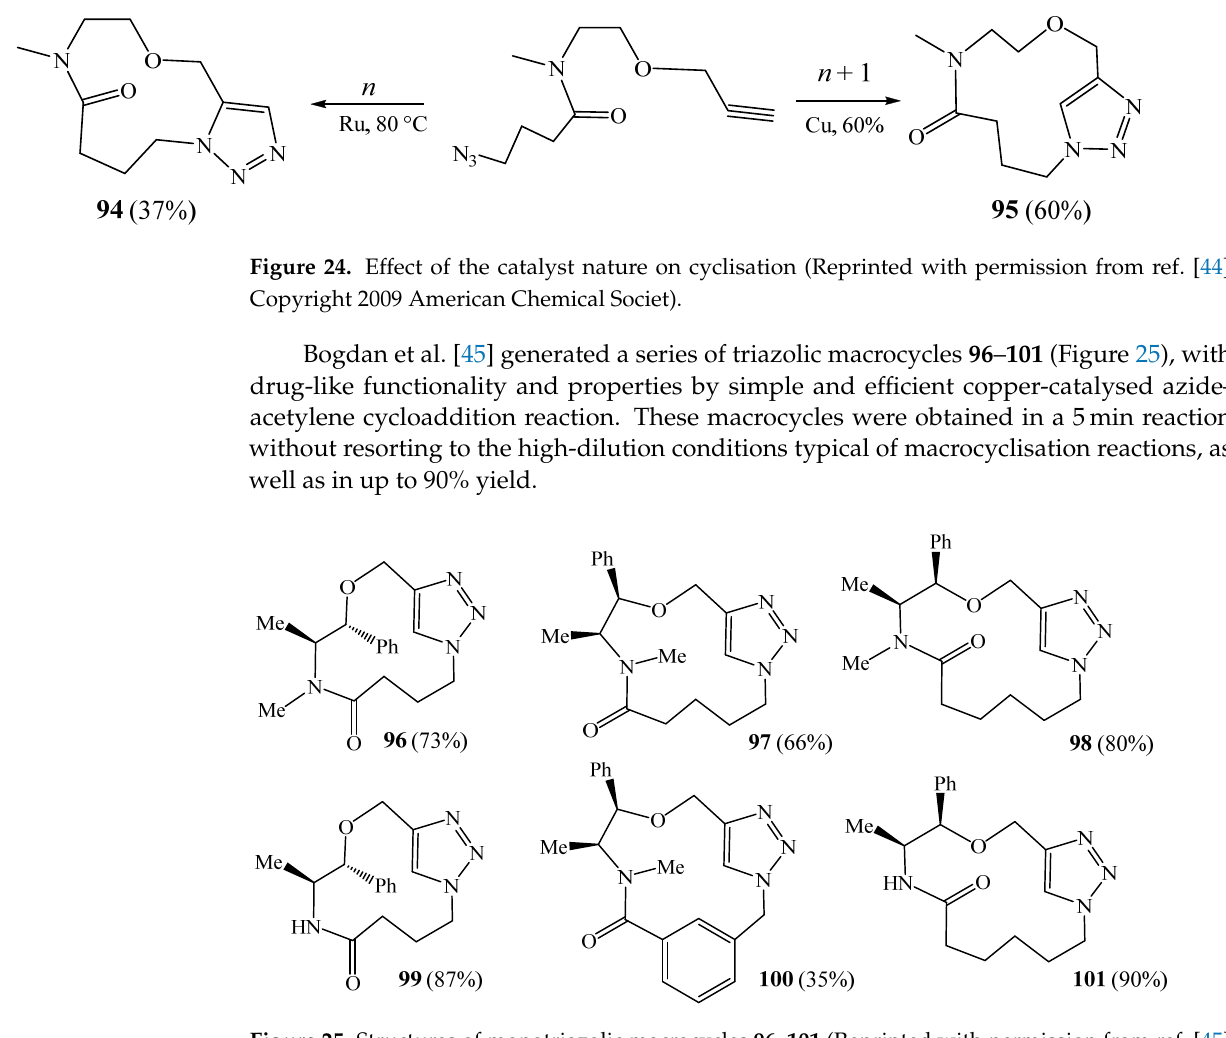
Figure 25. Structures of monotriazolic macrocycles 96 − 101. (Reprinted with permission from ref. [45]. Copyright 2010 John Wiley and Sons).